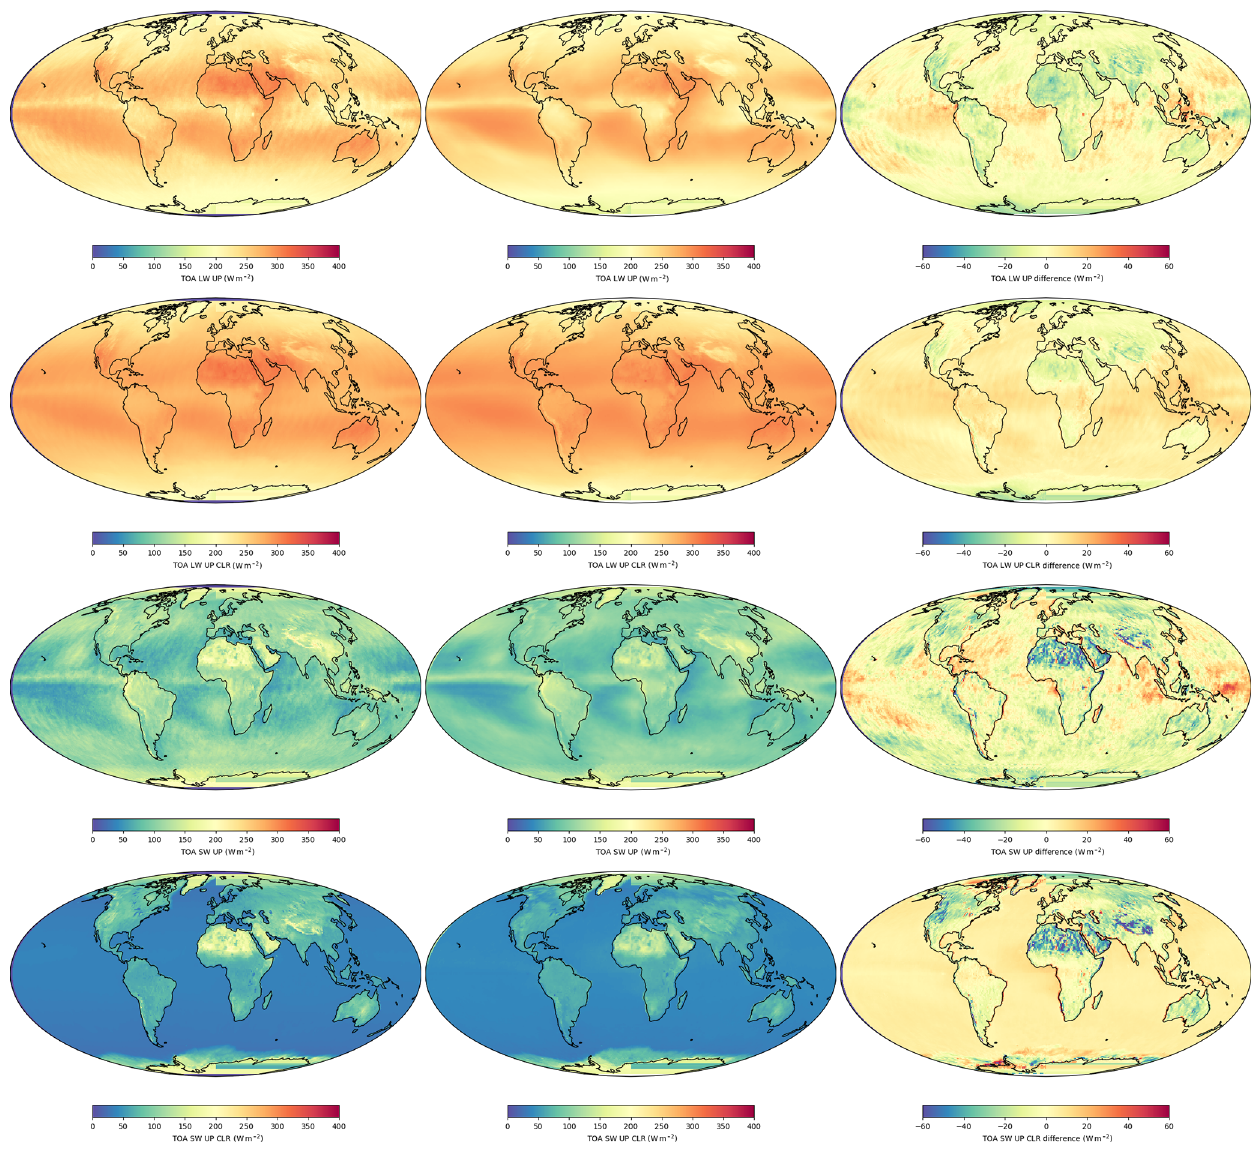
Figure 4. Examples of Level-3C (yearly average for 2008) Cloud_cci AATSR V3 (left column), CERES (middle column) and the difference between CERES and AATSR (right column): global maps of fluxes, from top to bottom, LWF up